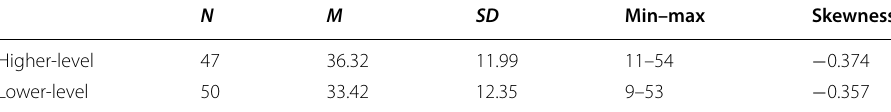
Notes . The possible minimum and maximum scores were 9 and